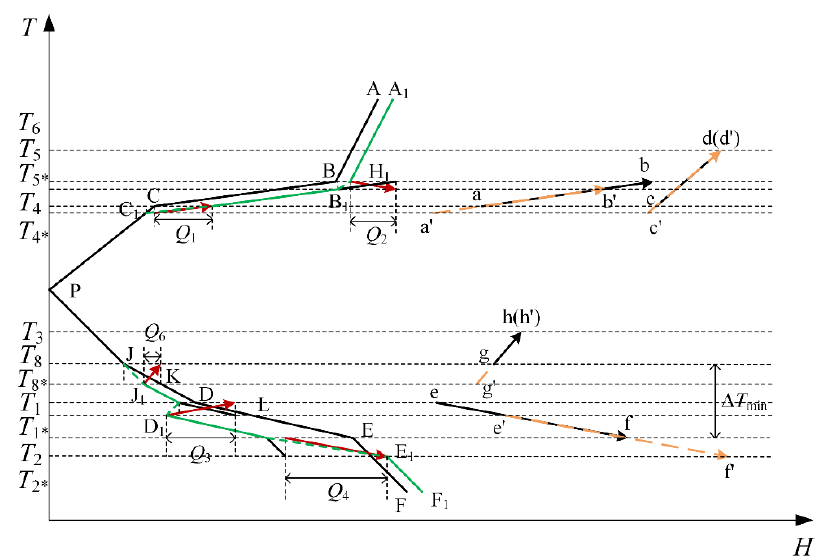
Figure 4. Variation of GCC for Case 3. Table 3. Changes of the pinch temperature and cold utility for Case 3